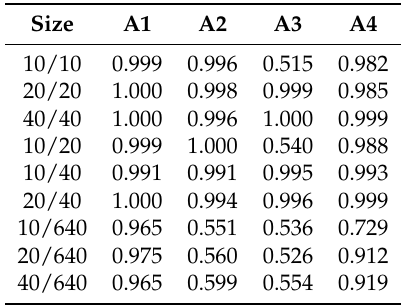
Figure 5. Distribution of a subset of the validation data in the latent space. The points are colored according to their corresponding groundtruth bass pattern. The background colors and isolines show the predictions of quadratic classifiers that predict the bass pattern from the latent variable. Table 2. Predictive accuracy of the quadratic